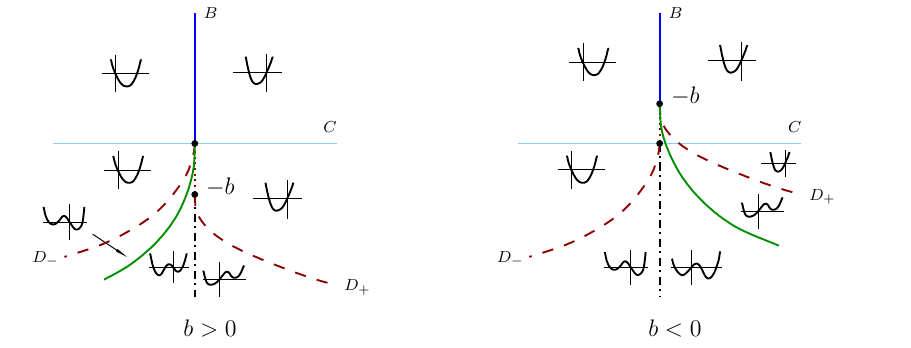
Figure 27 . Effective potential for Case II: A < 0 , A + a > 0 .